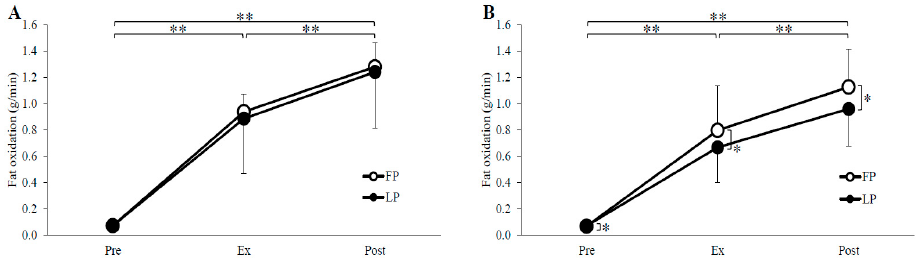
Figure 3. Fat oxidation for GTE ( A ) and PLA ( B ) trials. FP, follicular phase; LP, luteal phase; Pre, before exercise; Ex, 15 min during exercise; Post, immediately after exercise. * p < 0.05, ** p < 0.01.